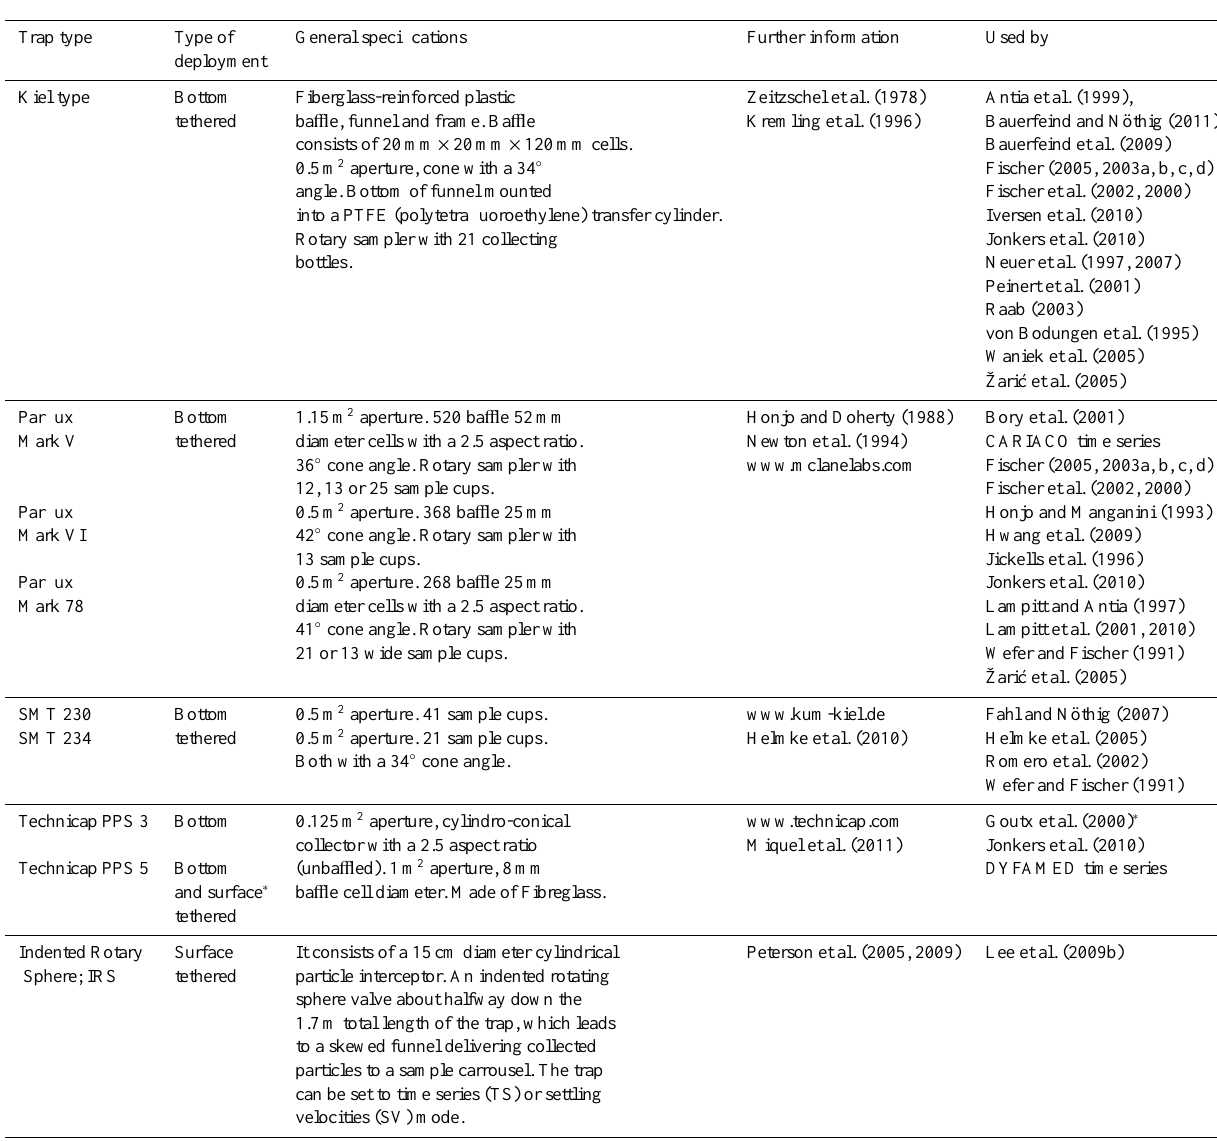
Table 3. Sediment-trap specifications